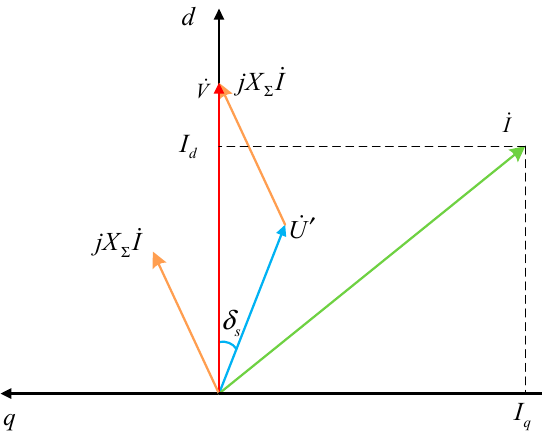
Figure 6. Vector diagram of system at the moment of power grid fault.